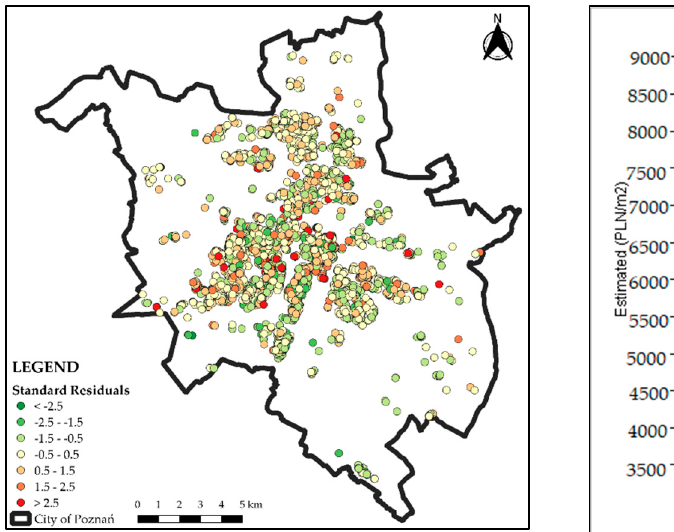
11 of 22 Table 4. Summary of ordinary least squares (OLS) regression results. Coefficient